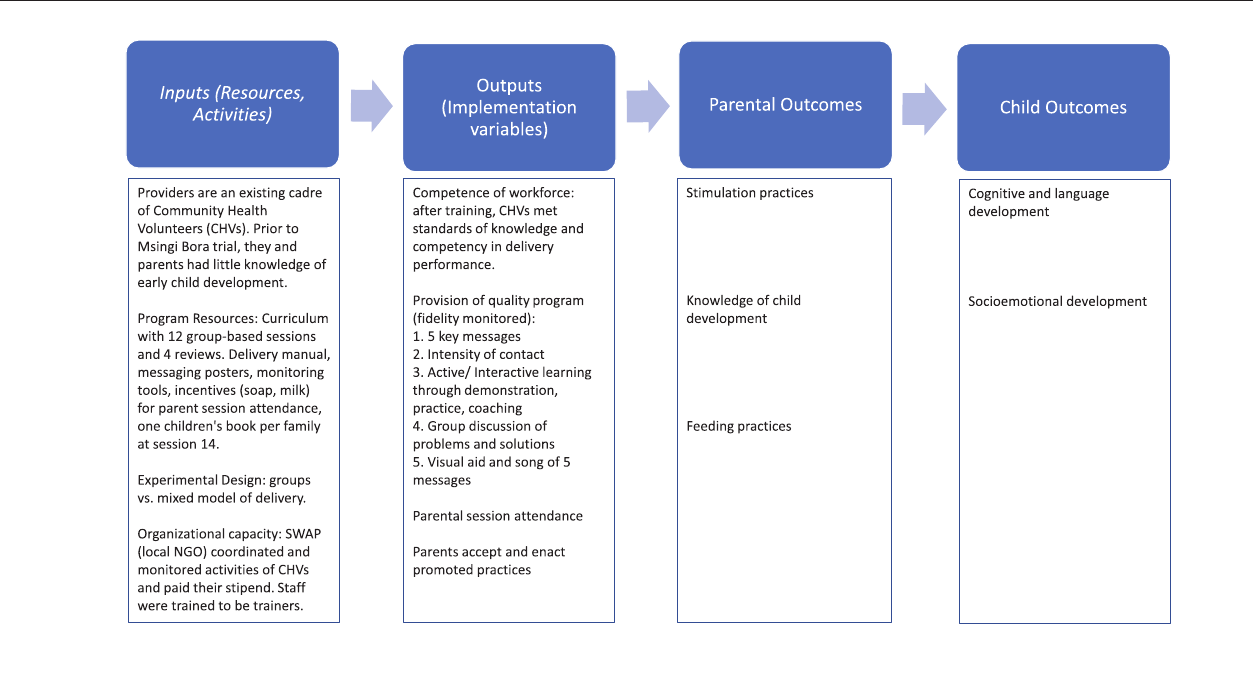
FIGURE 1 | Logic model. Child and parent outcome indicators are reported in Luoto et al. (14).